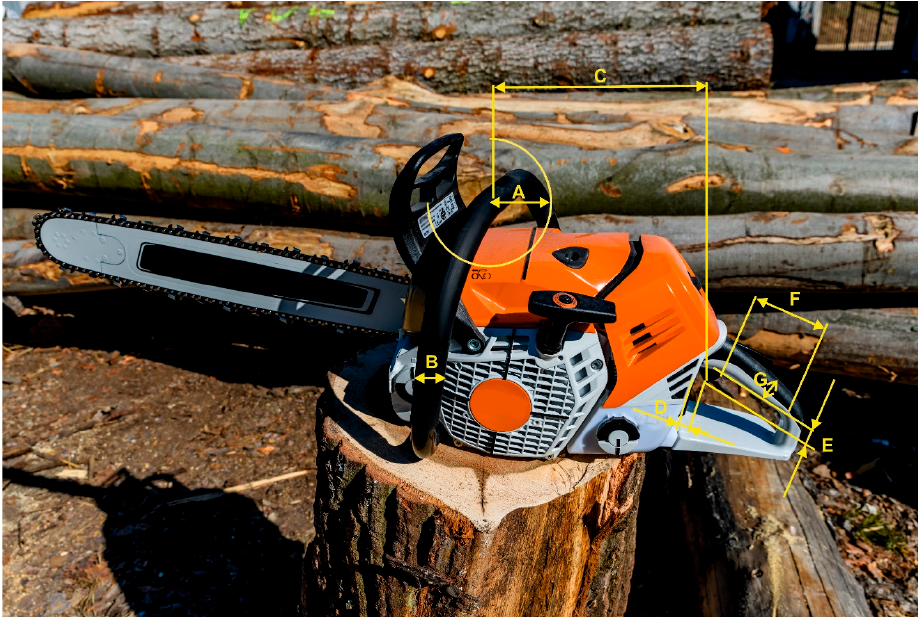
Figure 2. Chainsaw handle clearances and sizes according to Table